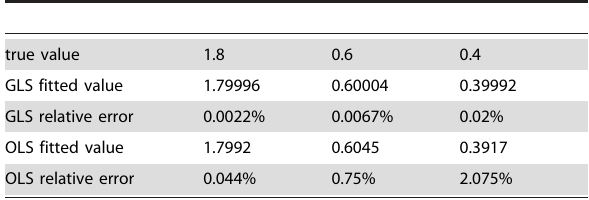
Table 3. Two-stage estimates for b OLS.